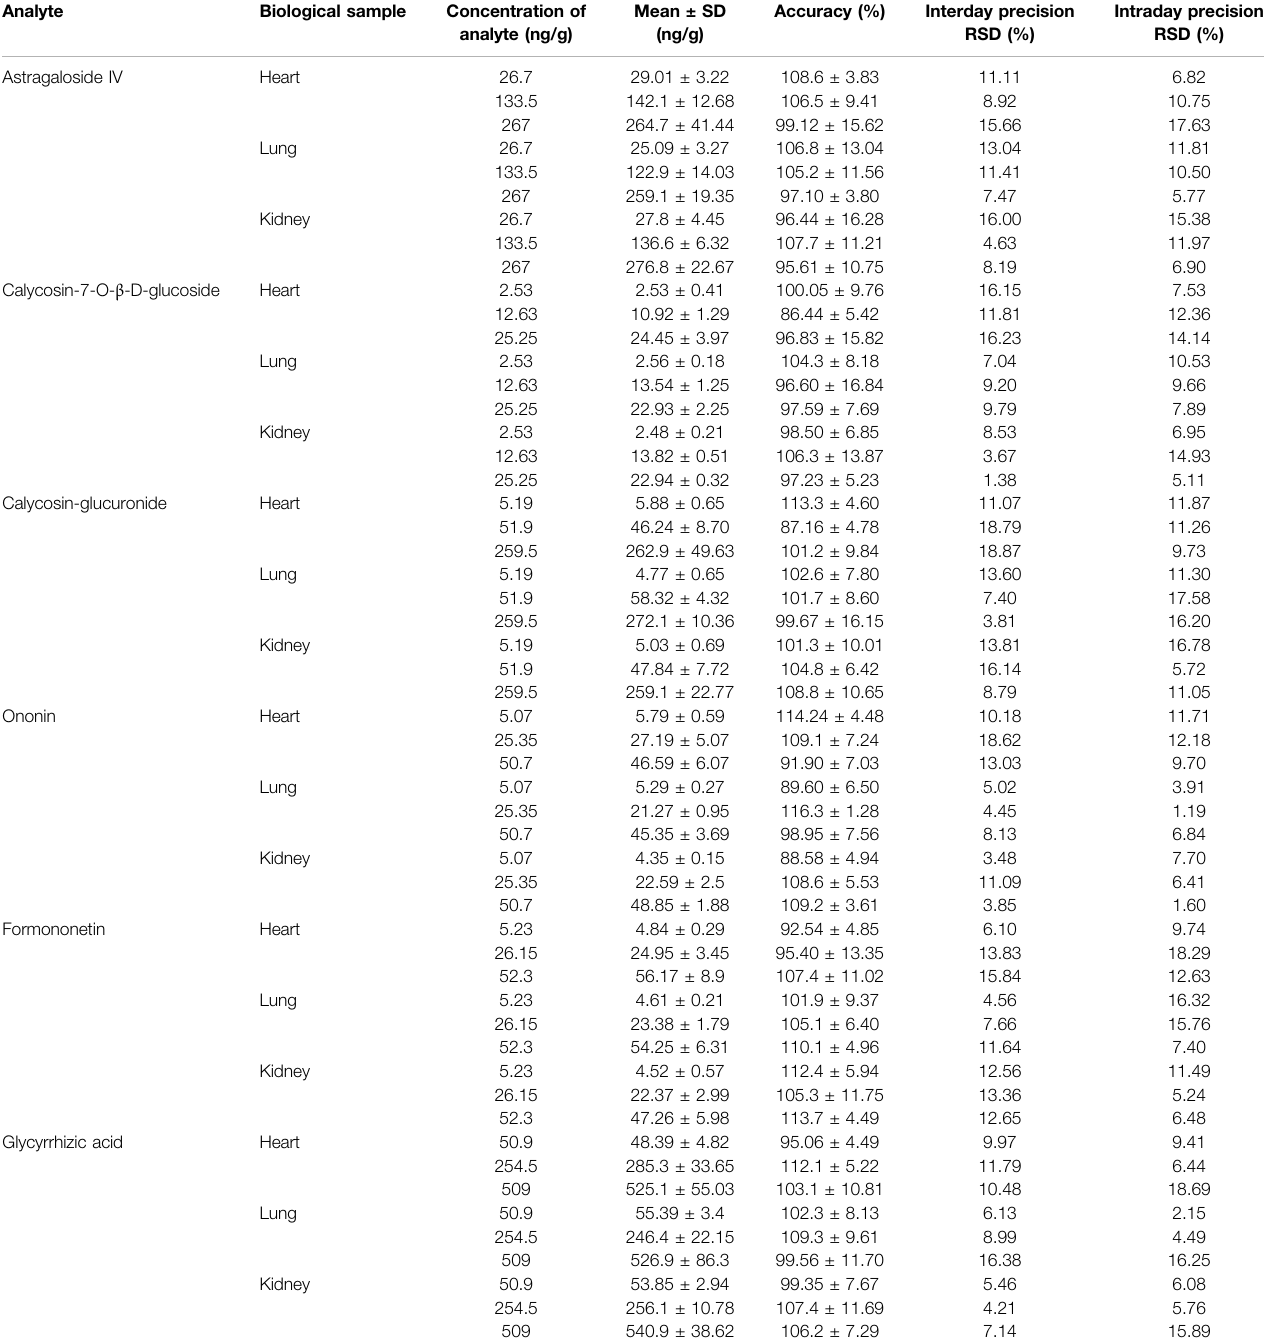
TABLE 3 | Precision and accuracy of ingredients in tissue homogenate samples ( ‾ x ± SD; n = 6).